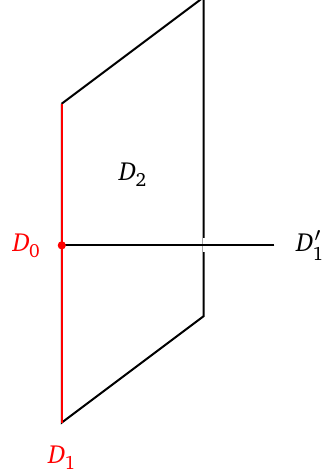
Figure 2: An example of a non-genuine defect arising at the junctions of genuine and other non-genuine defects. Here D is a non-genuine local operator that can arise at 0 an end of D 1 along D , where D 1 is a genuine line defect, while D 1 1 1 genuine line defect that can arise at an end of the genuine surface defect D